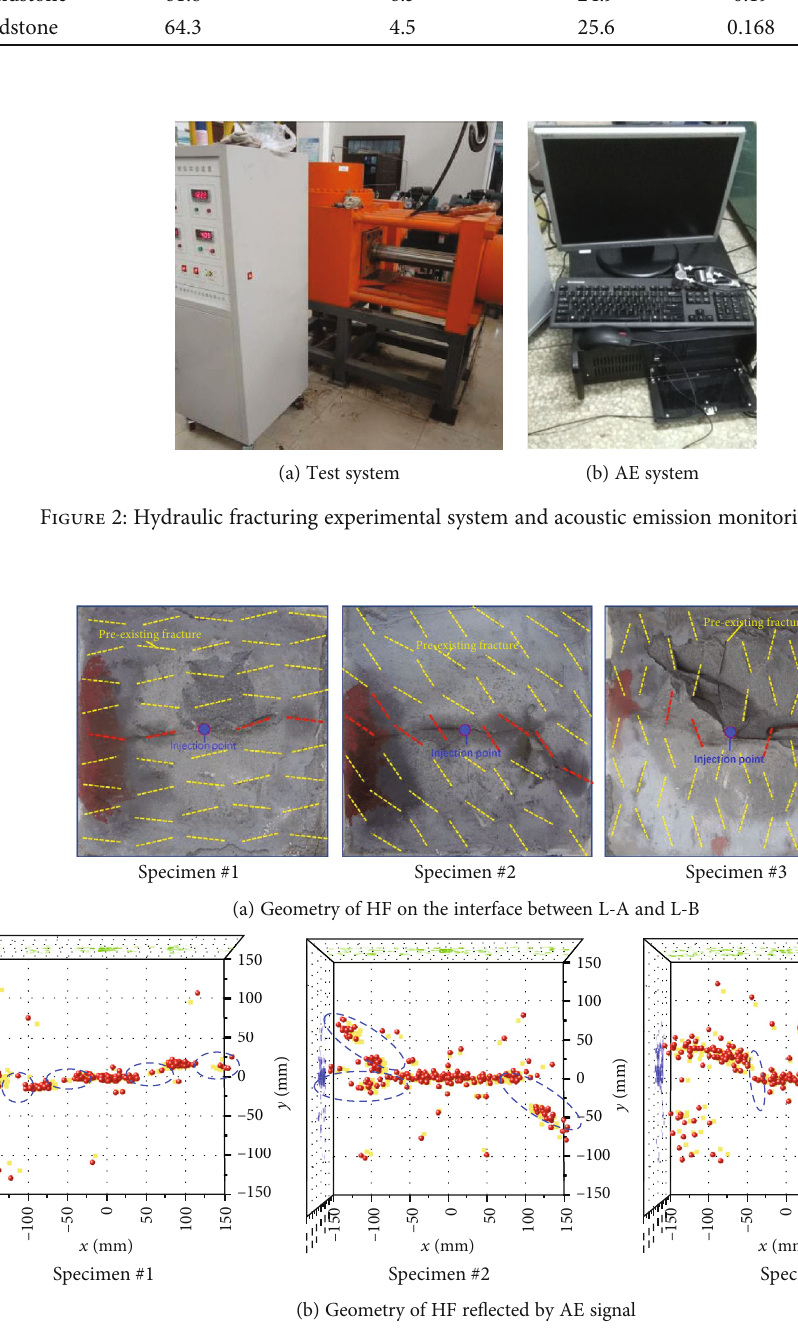
Figure 3: Hydraulic fracture morphology observed in the cross-section of the fractured specimen and re fl ected by AE